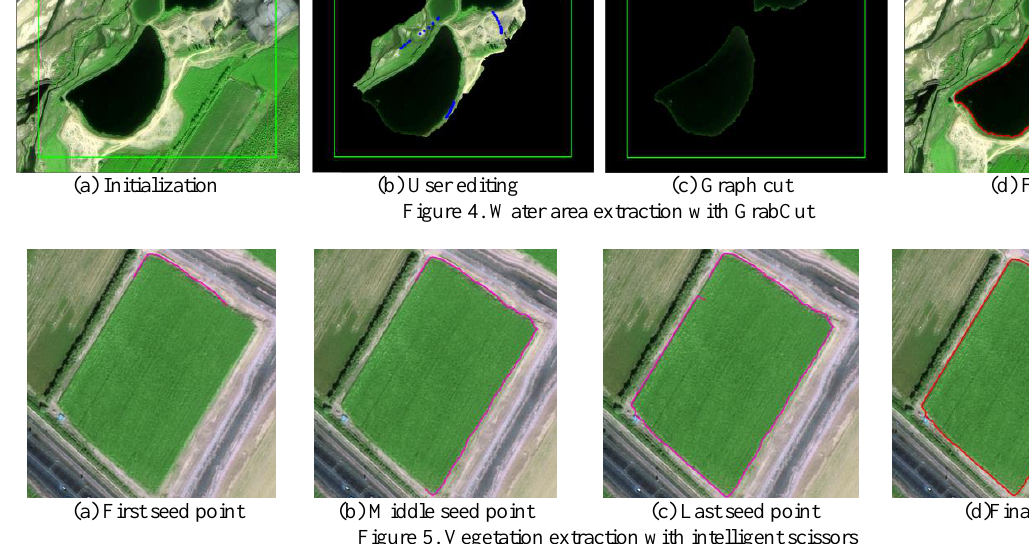
Figure 5. Vegetation extraction with intelligent scissors